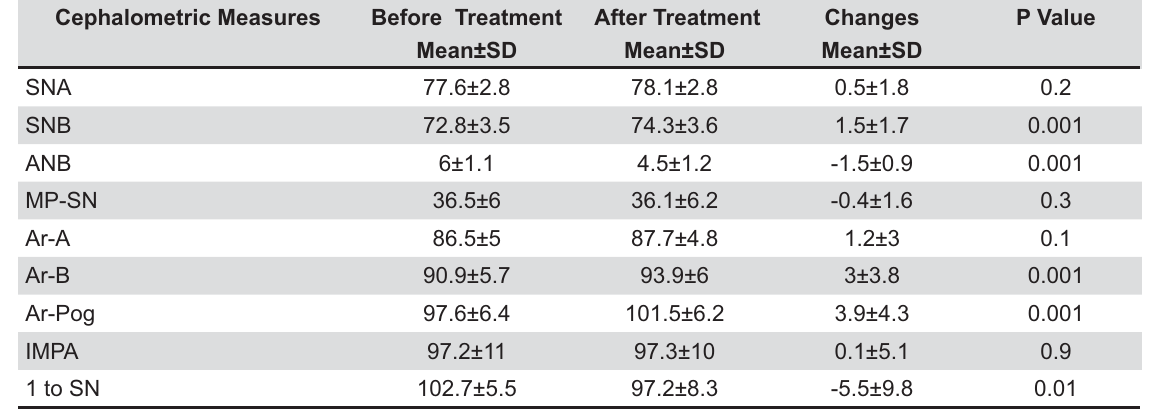
Table 2- Pretreatment and posttreatment measurements of Anterior Inclined Bite Plate (AIBP)